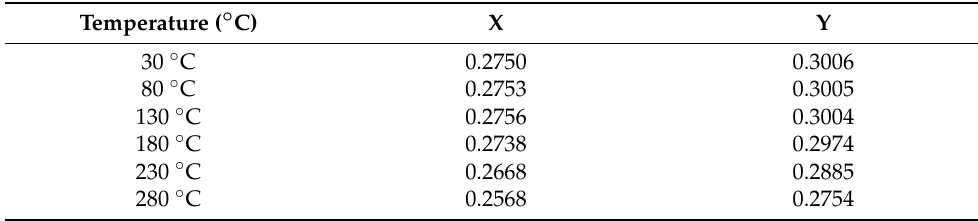
Figure 3. CIE coordinates diagram of Ca 1.8 Li 0.6 La 0.57 (PO 4 ) 2 :0.03Dy 3+ . Phosphor at different temperatures. Table 3. CIE coordinates of Ca 1.8 Li 0.6 La 0.6 − x (PO 4 ) 2 :xDy 3+ at different